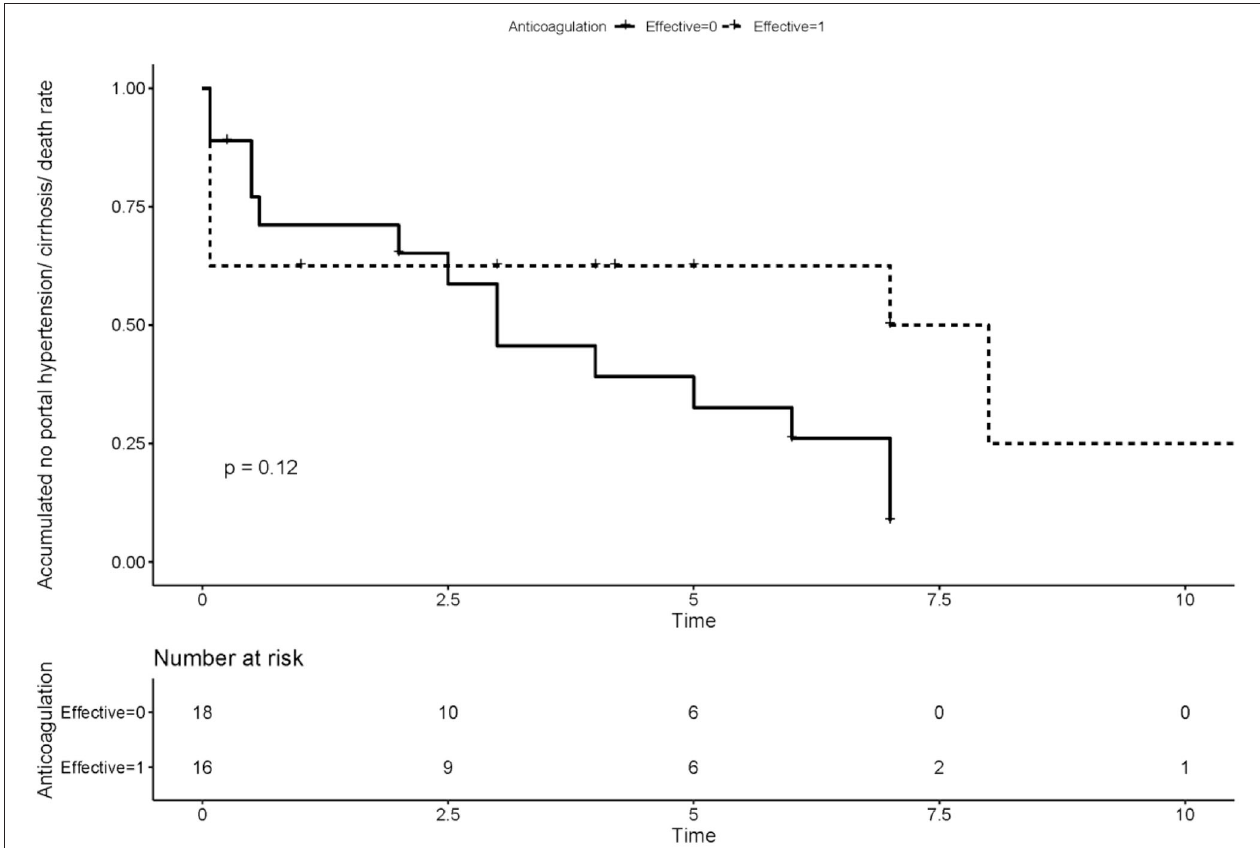
FIGURE 4 | Difference of accumulated no comprehensive adverse events (portal hypertension, cirrhosis, and death) rate between groups receiving effective anticoagulation ( n = 16) and not ( n = 18). Effective anticoagulation was defined as immediate and sufficient anticoagulant therapy for at least 6 months with a target international normalized ratio (INR) of 2.0–3.0 from the time of portal vein thrombosis (PVT)